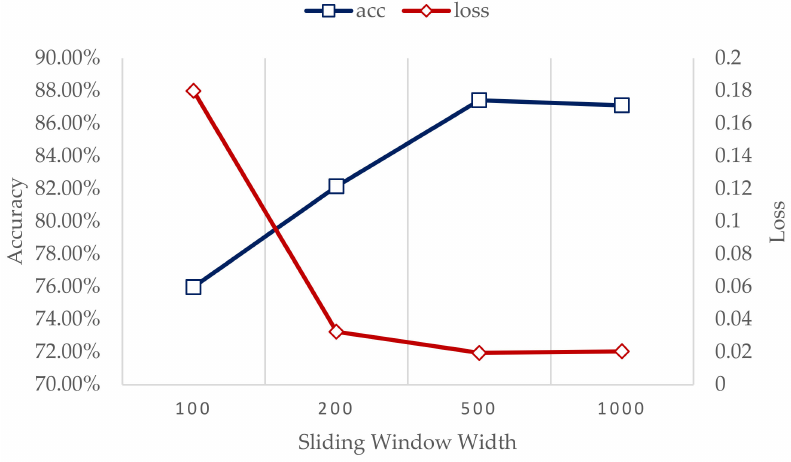
Figure 10. Model accuracy and loss with different sliding window